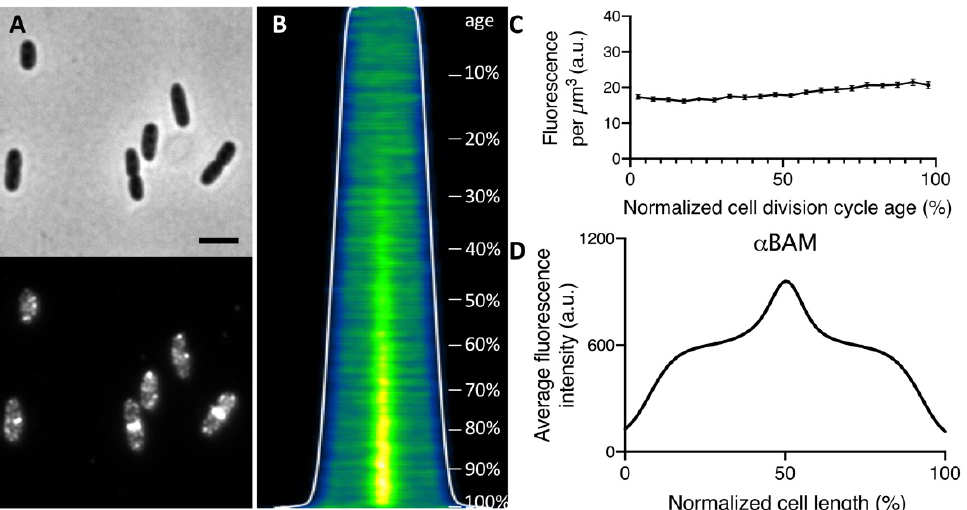
Figure 1. E. coli wild type cells LMC500 immunolabelled with polyclonal antibodies against BAM ( α BAM). ( A ) Phase contrast and fluorescence microscopy images show the wild type grown to steady state in minimal medium at 28 °C and immunolabelled for the Bam complex. Scale bar equals 2 µ m. ( B ) In the demographic map, the cells are sorted by cell length and the cell division cycle age is indicated (%). The longer/older cells clearly show BAM midcell localization from 40% onwards. ( C ) Concentration of the BAM fluorescence signal plotted as function of the normalized cell division cycle age shows an almost constant BAM production. The fluorescence concentration markers are the values of 5% age bins with the 95% confidence range indicated by the error bars. ( D ) The average profile of the fluorescence intensity plotted as function of the normalized cell length exhibits a